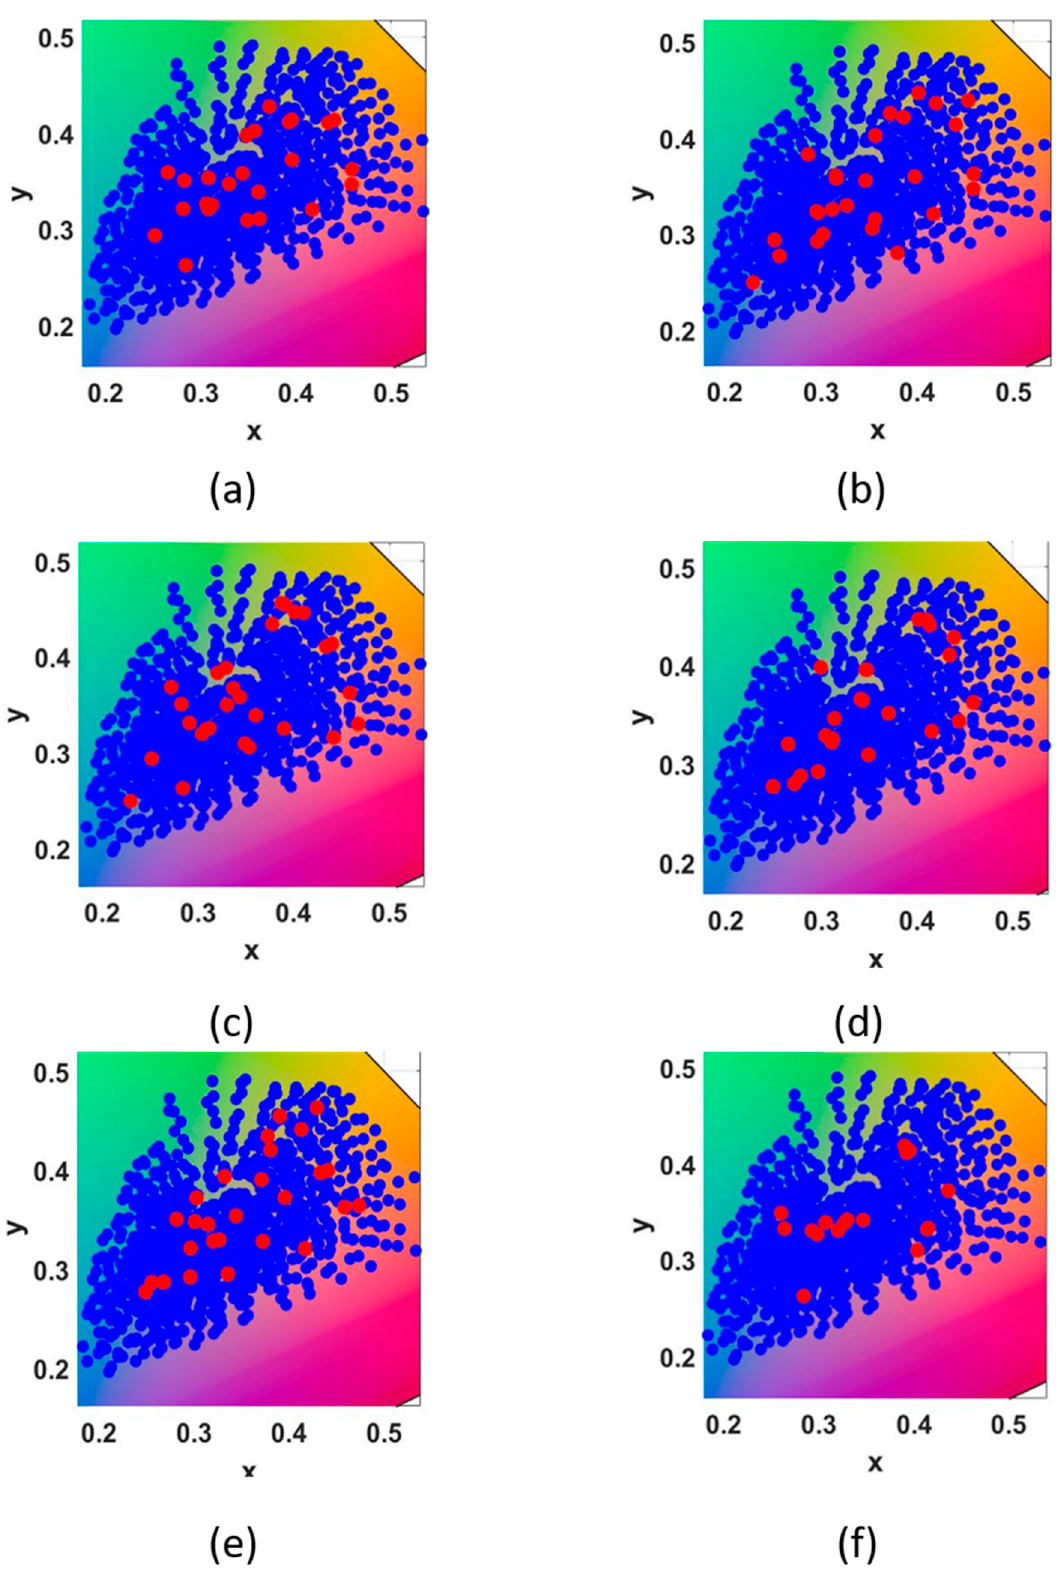
Figure 11. The distribution of training samples and representative samples selected by different illuminants in xyY space, respectively: ( a ) B, ( b ) C, ( c ) D50, ( d ) D65, ( e ) E and ( f )